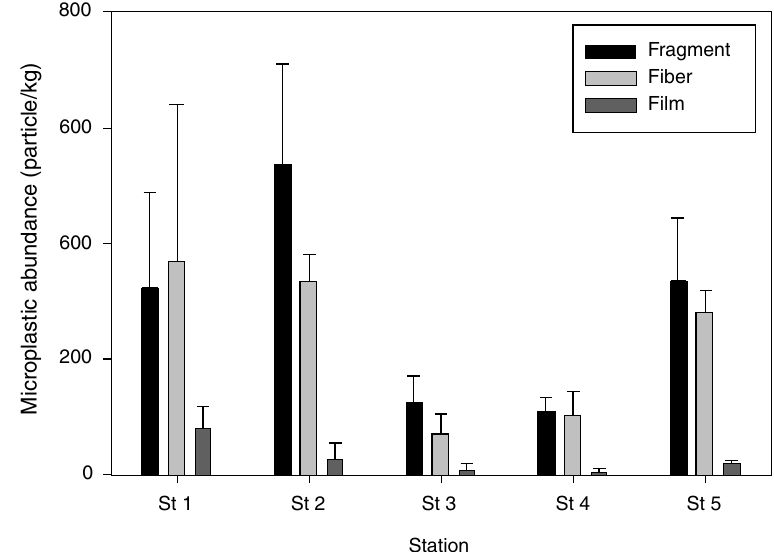
Figure 3. The average abundance (n=3) of the type of microplastics collected from the eastern water of Java